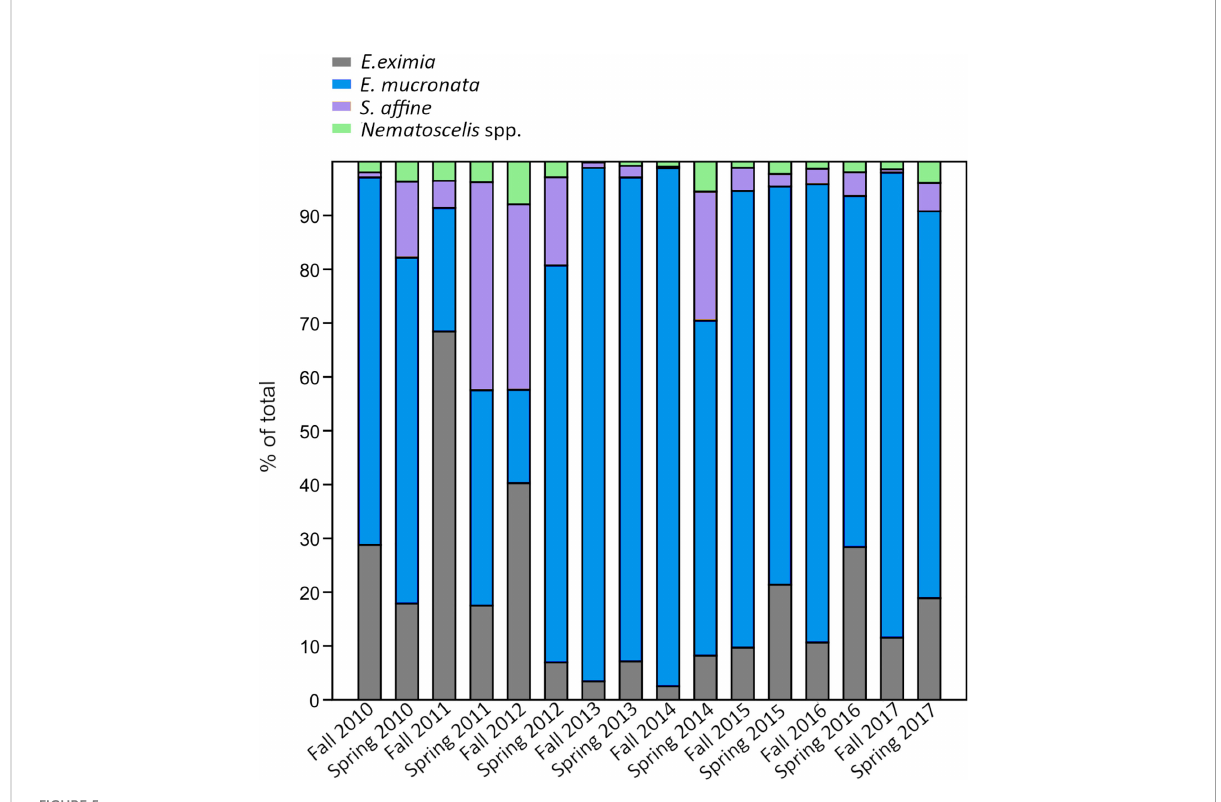
FIGURE 5 Percentage of contribution of each euphausiid taxon to total abundance, for each sampling